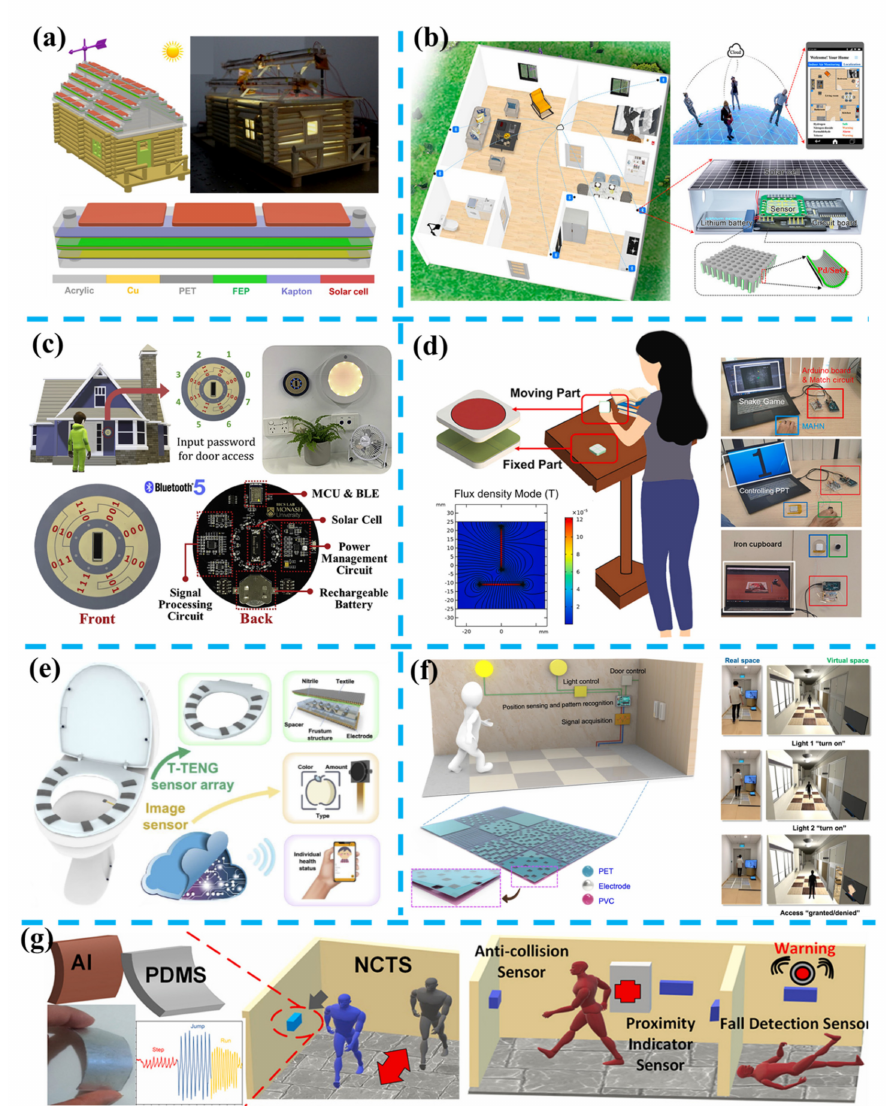
Figure 4. Smart home. ( a ) Roof for scavenging solar and wind energies (Reprinted with per- mission from ref. [170]. Copyright 2016 American Chemical Society). ( b ) Wireless self-powered high-performance integrated nanostructured-gas-sensor network (Reprinted with permission from ref. [174]. Copyright 2021 American Chemical Society). ( c ) Self-powered control interface for access- ing based on Gray code with hybrid triboelectric and photovoltaics energy harvesting (Reprinted with permission from ref. [176]. Copyright 2020 Elsevier). ( d ) Noncontact control interface based on magnetic-interaction assisted hybridized triboelectric-electromagnetic nanogenerator (Reprinted with permission from ref. [177]. Copyright 2021 Elsevier). ( e ) AI-Toilet for an integrated health monitoring system (IHMS) using smart triboelectric pressure sensors and an image sensor (Reprinted with permission from ref. [178]. Copyright 2021 Elsevier). ( f ) Smart mats as a scalable floor moni- toring system enabled by deep learning (Reprinted with permission from ref. [8]. Copyright 2020, Nature). ( g ) Contactless tracking of humans in a smart home using non-contact triboelectric sensing technology (Reprinted with permission from ref. [179]. Copyright 2021